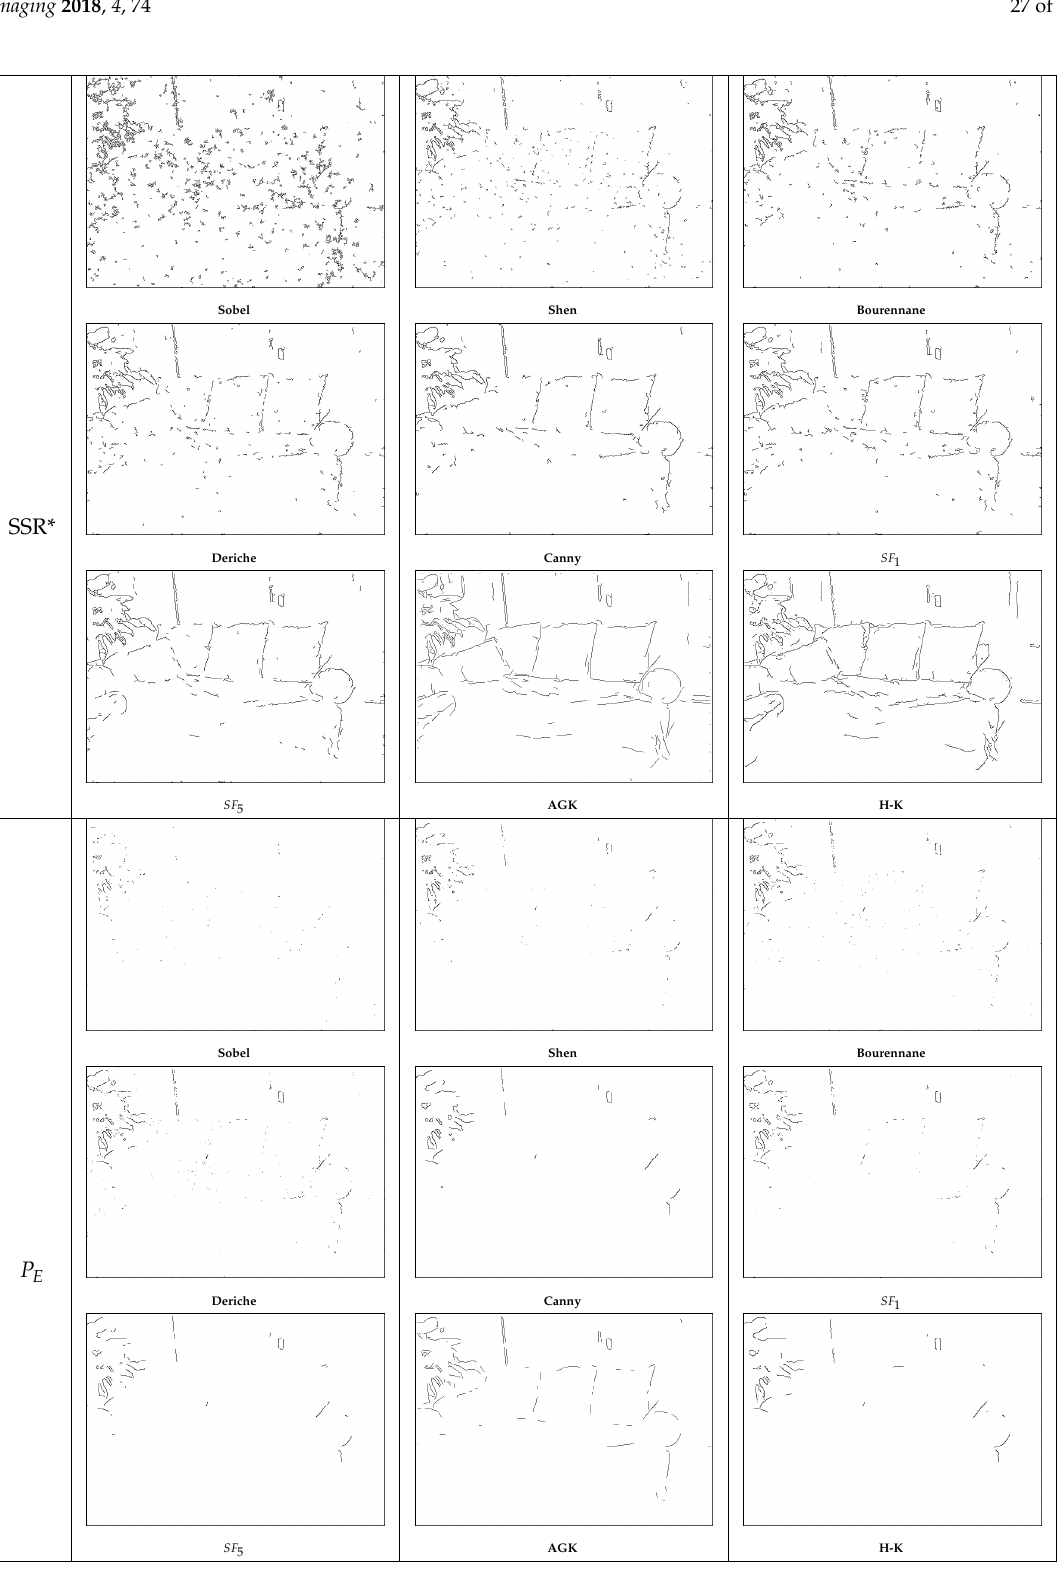
Figure 21. Ideal segmentations for several edge detectors on image 109, PSNR = 14